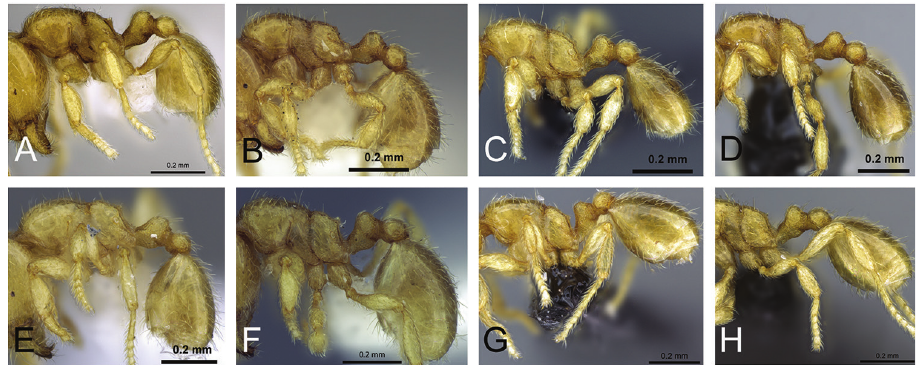
Figure 25. Body in profile view of A Carebara mahafaly (CASENT0410535) B Carebara salegi (CASENT0438115) C Carebara lova (CASENT0468562) D Carebara omasi (CASENT0028947) E Carebara tana (CASENT0438084) F Carebara kabosy (CASENT0437739) G Carebara raberi